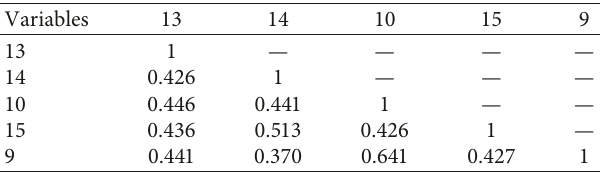
Table 7: Pearson correlation coefficient matrix for the variables in factor 2.